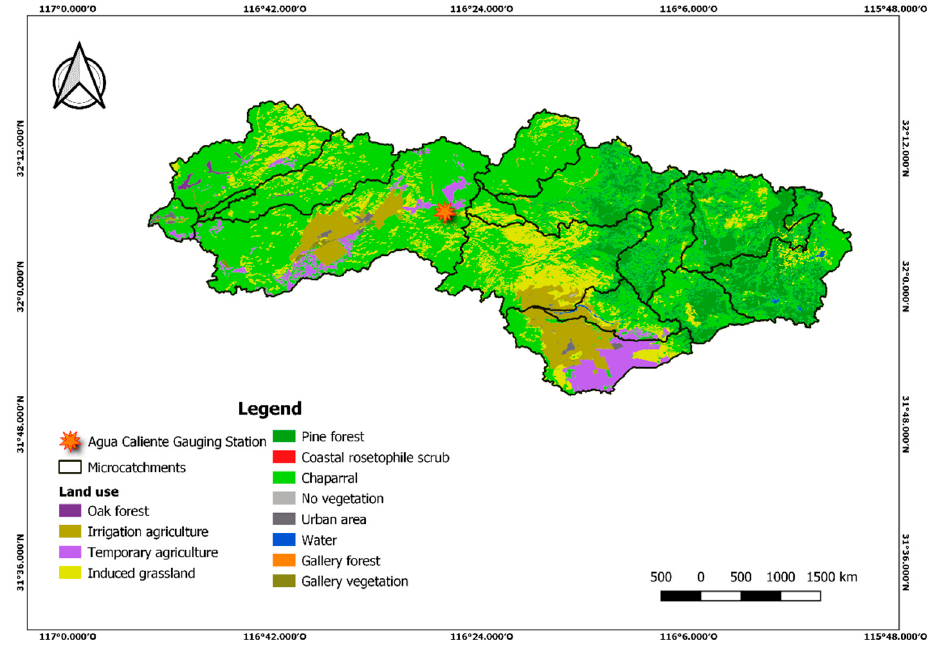
Figure 5. Map of Land Uses.